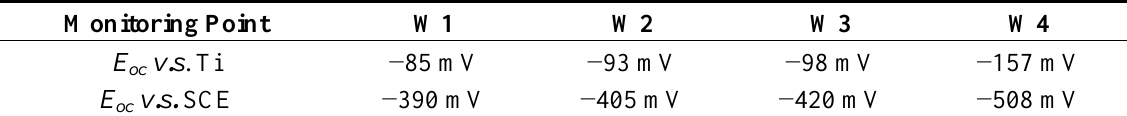
Table 2. Potential of monitoring